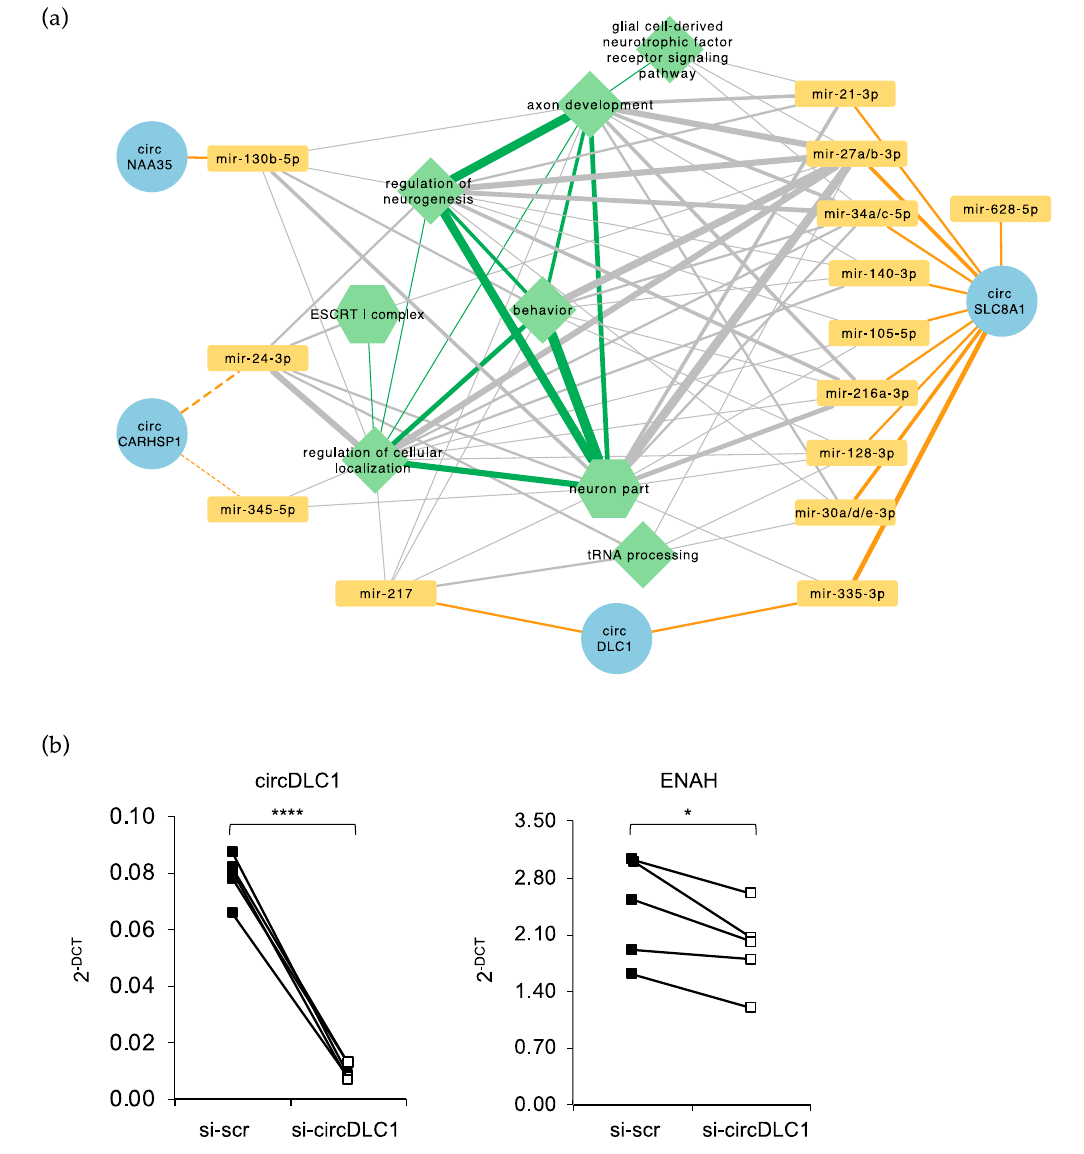
Figure 6. circRNA–miRNA–mRNA network inferred from high-throughput data. ( a ) The network reports the downregulated cytoplasmic circRNAs predicted to act as sponges for miRNAs expressed in MNs. Orange edges connect circRNAs to miRNAs, for which they have at least two predicted binding sites, or at least one binding region spanning the back-splicing junction (dashed lines), the edge width being proportional to the number of sites. Green nodes correspond to the GO Biological Process (hexagons) or Molecular Function (diamonds) terms enriched among all the known or predicted targets of sponged miRNAs (see Materials and Methods); only targets whose mRNA and/or protein are downregulated upon FUS mutation were used. Gray edges connect miRNAs to the functional categories to which at least one target belongs, the edge width being proportional to the number of targets. Green edges connect categories with at least one target gene in common, the width being proportional to the number of shared genes. ( b ) Plots showing the levels of the circDLC1 and ENAH mRNA measured by quantitative Real-Time PCR in MNs treated with si-circDLC1 and with si-scr as the control. RNA levels were quantified using ATP5O mRNA levels as the reference and expressed as 2 ^- Δ CT. Values from all the biological replicates ( n = 5) are shown. p -values were calculated using paired two-tailed Student’s t -test (* p < 0.05 and **** p < 0.0001). Finally, we decided to validate the predicted circRNA sponge activity by downregu- lating circDLC1 in MNs through siRNA treatment and by using quantitative